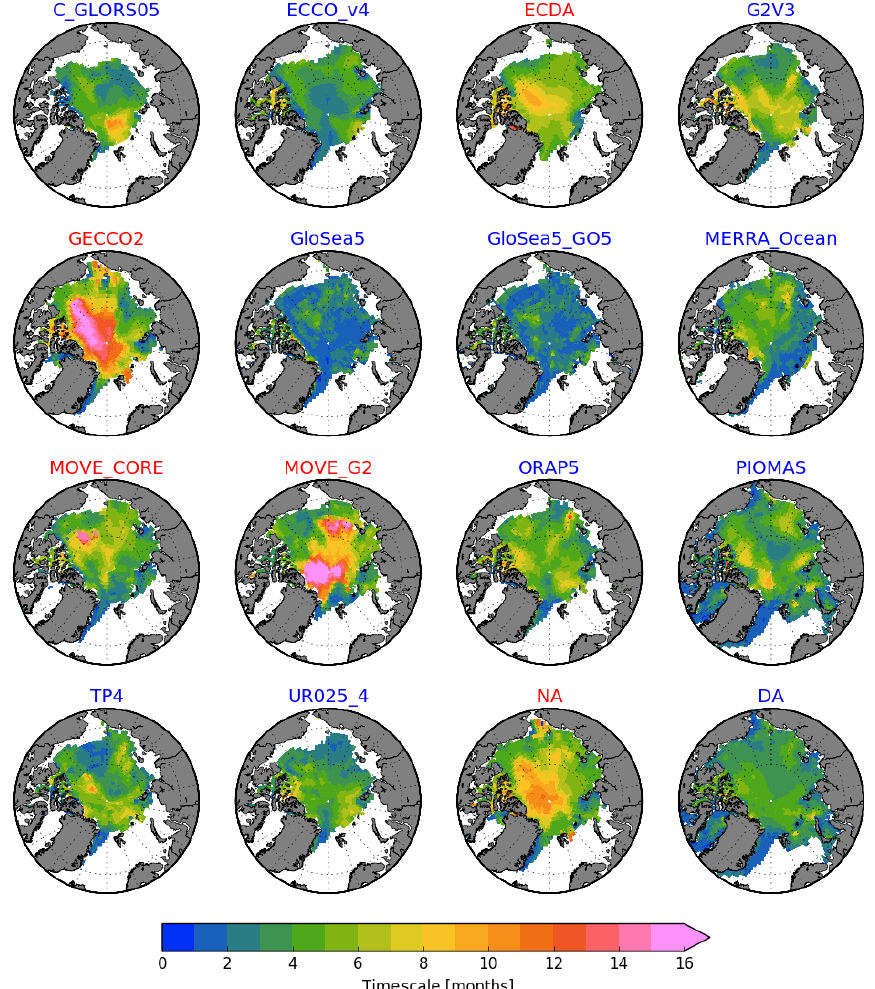
Figure 6. The e -folding timescales (or persistence) estimated for the SIT time series. Only grid cells in which the time mean (for the January 1993–December 2007 period) SIT at the time of summer minimum is greater than 0.1m are taken into account for the computations. Averages for the systems with ice data assimilation and no data assimilation are represented by the DA and NA panels, respectively. All maps have the 0 ◦ longitude placed at 06:00, while the bounding latitude is 67 ◦ N. Reanalyses labeled in blue and red highlight whether the datasets were built with or without ice data assimilation,